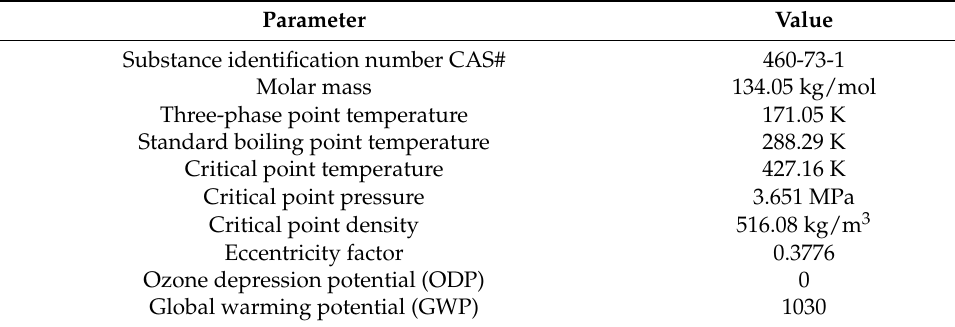
Table 5. Thermodynamic properties of R245fa.